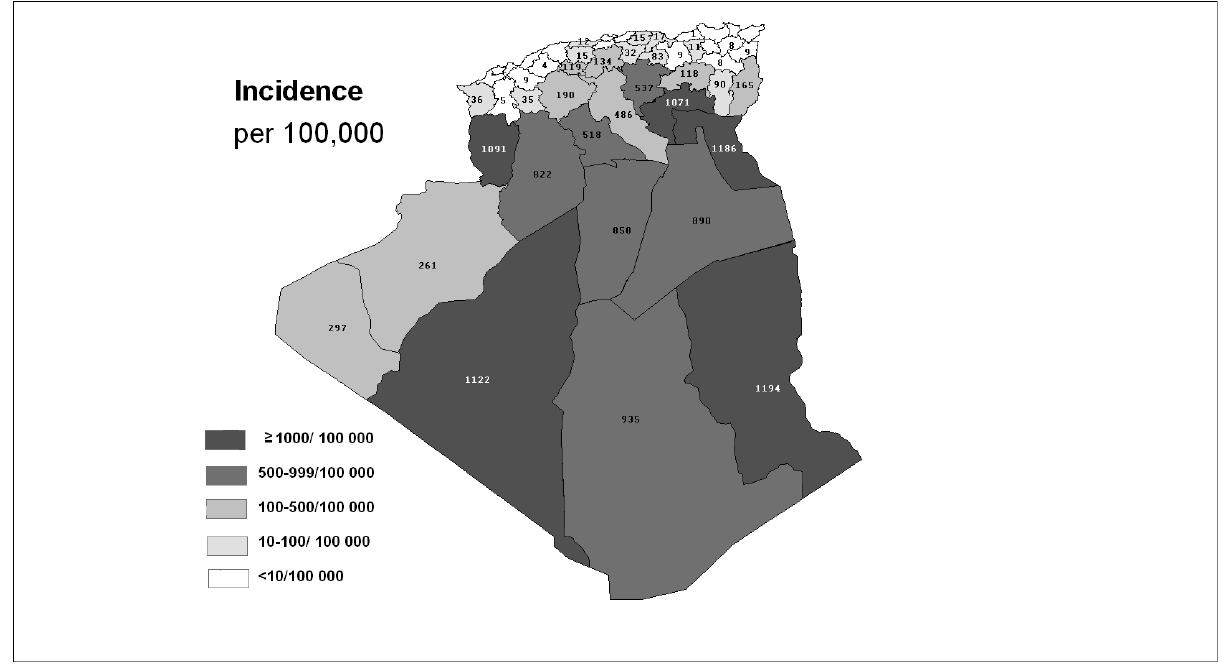
Figure 1. Geographical distribution of annual incidence of scorpion stings in Algeria (2001-2010).